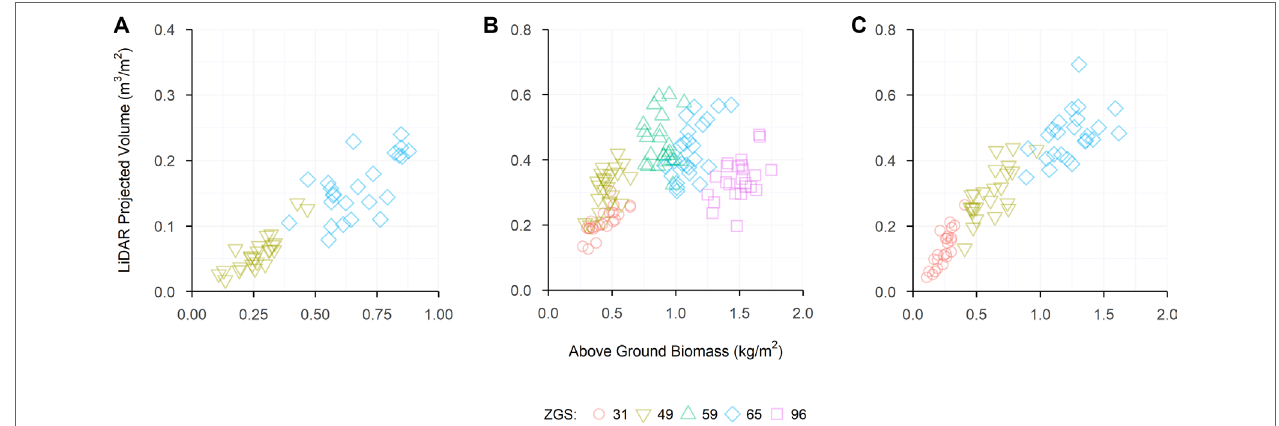
FIGURE 8 | The relationship between LiDAR Projected Volume and Above-ground Biomass for each sample time collected at Angas Valley (A) , Roseworthy (B) and Winulta (C) . Coloured shapes indicate measurements collected at Zadoks growth scales (ZGS) as follows, red circles at ZGS 31, yellow triangles at ZGS 49, green triangles at ZGS 59, blue diamonds at ZGS 65 and pink squares at ZGS 90.